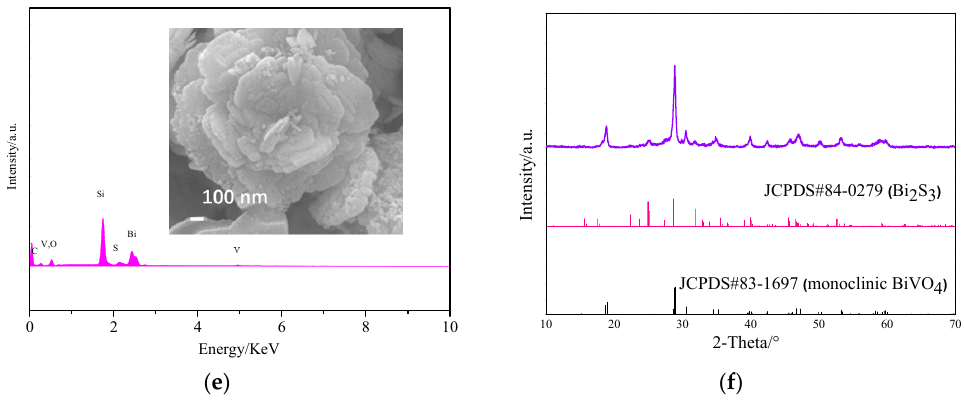
Figure 5. ( a ) Adsorption–desorption equilibrium test results; ( b ) Degradation of rhodamine B (RhB) using different catalysts under visible light irradiation; ( c ) Linear fit of the photocatalytic reaction and the reaction rate constant k; ( d ) Photocatalytic degradation of RhB reusing photocatalyst sample 8 after filtration; ( e ) EDX and SEM (inset) of sample 8 after recycling five times; ( f ) XRD of sample 8 after recycling five times. Table 2. Brunner − Emmet − Teller (BET) measurements of samples.